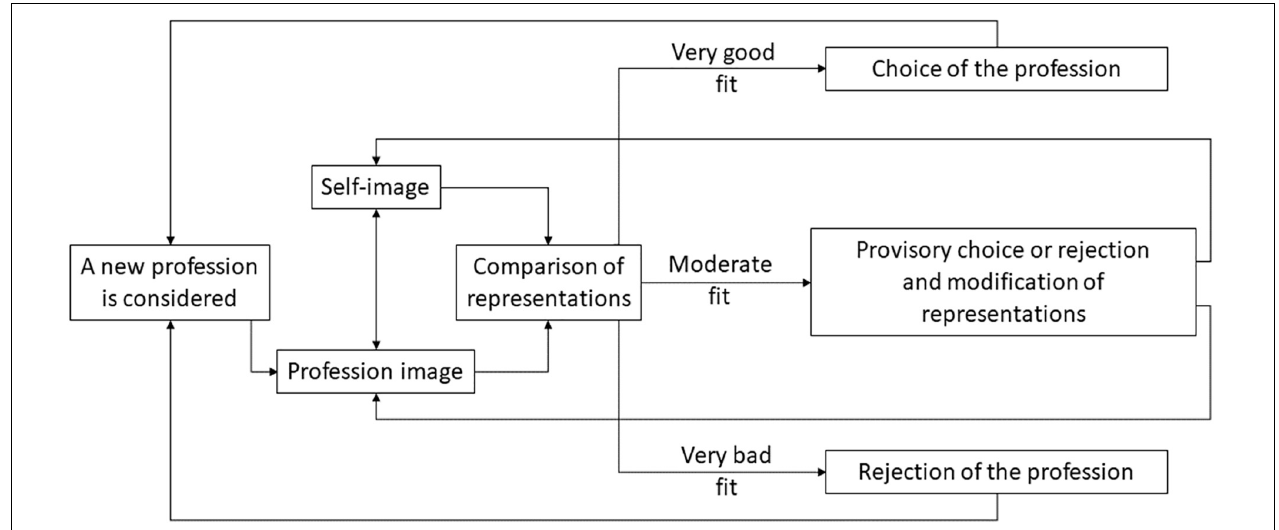
FIGURE 5 | The selection of preferences for trainings or professional activities. Note. Reproduced and translated from Brillet and Gavoille (2016,